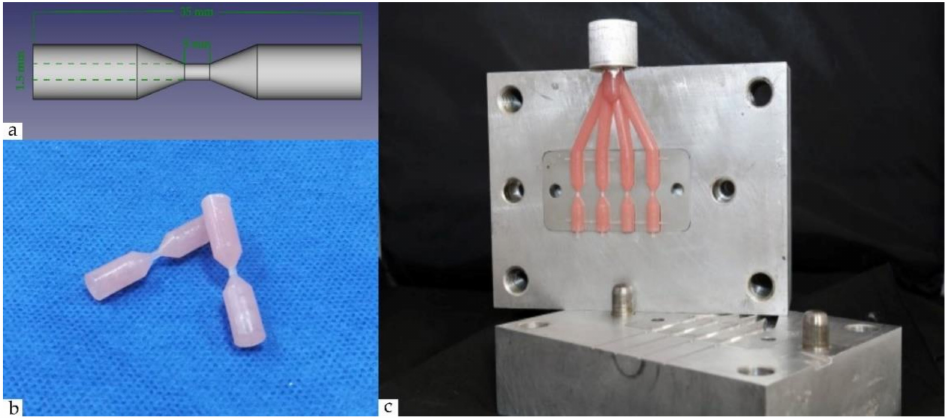
Figure 2. Test specimens’ fabrication: ( a ) design; ( b ) finished test samples, ( c ) matrix form with injected